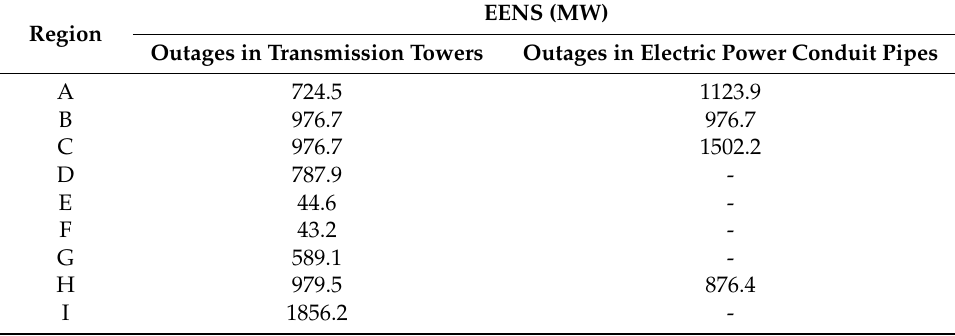
Table 1. Simulation Result of the Expected Energy Not Served (EENS) for severe scenarios. EENS (MW) Region Outages in Transmission Towers Outages in Electric Power Conduit Pipes 724.5